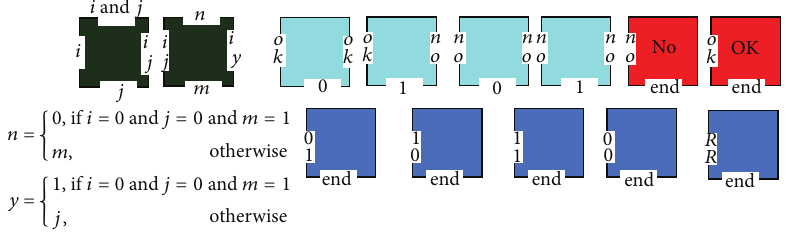
Figure 5: The meaning of tiles in 𝑇 𝑘 with 𝑖,𝑗, 𝑚, 𝑛,𝑦 ∈ {0,1} .